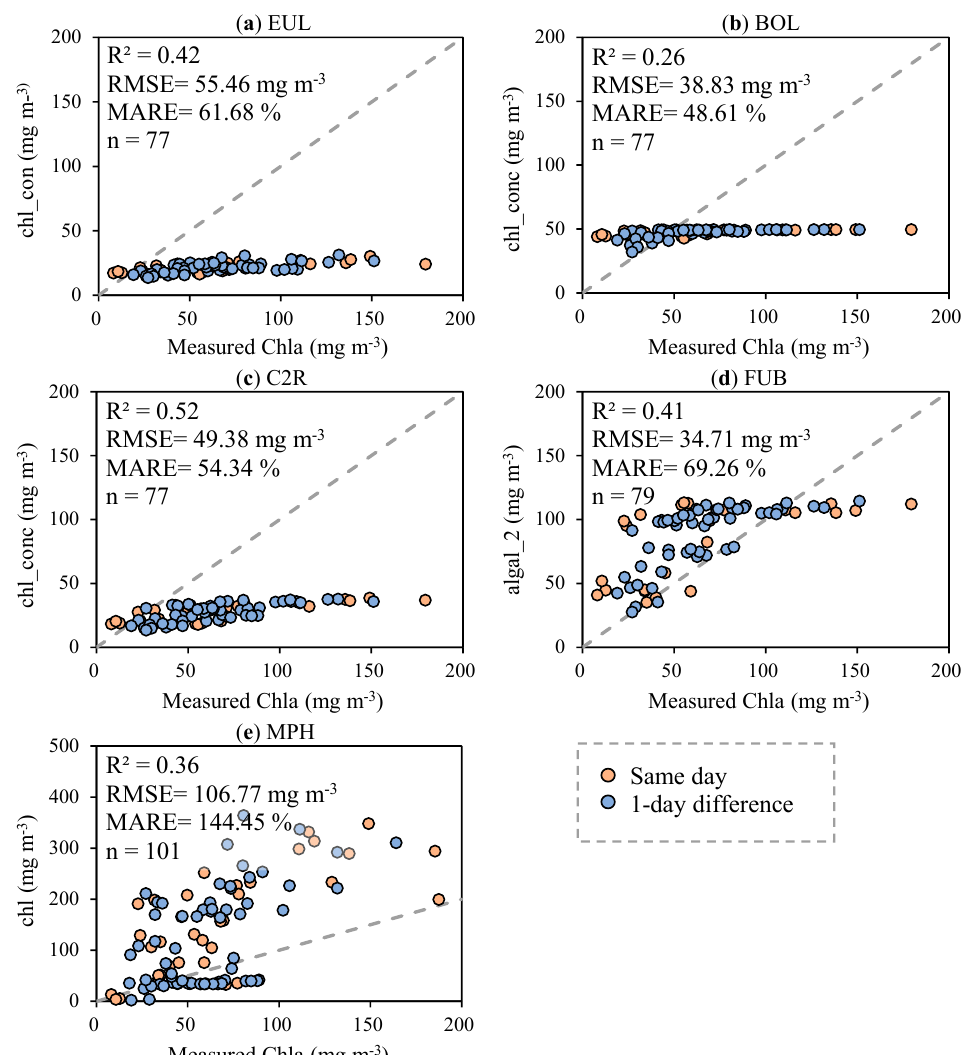
Figure 5. Comparison of the measured and retrieved Chla from ( a ) EUL; ( b ) BOL; ( c ) C2R; ( d ) FUB; and ( e ) MPH processors. chl_conc indicates the chlorophyll-a (Chla) concentration retrieved from EUL, BOL, and C2R processors; algal_2 and chl stand for the retrieved Chla from the FUB and MPH processors, respectively; FLH and MCI denote indices correlated with Chla concentrations; n represents the total number of match-ups available for each processor.